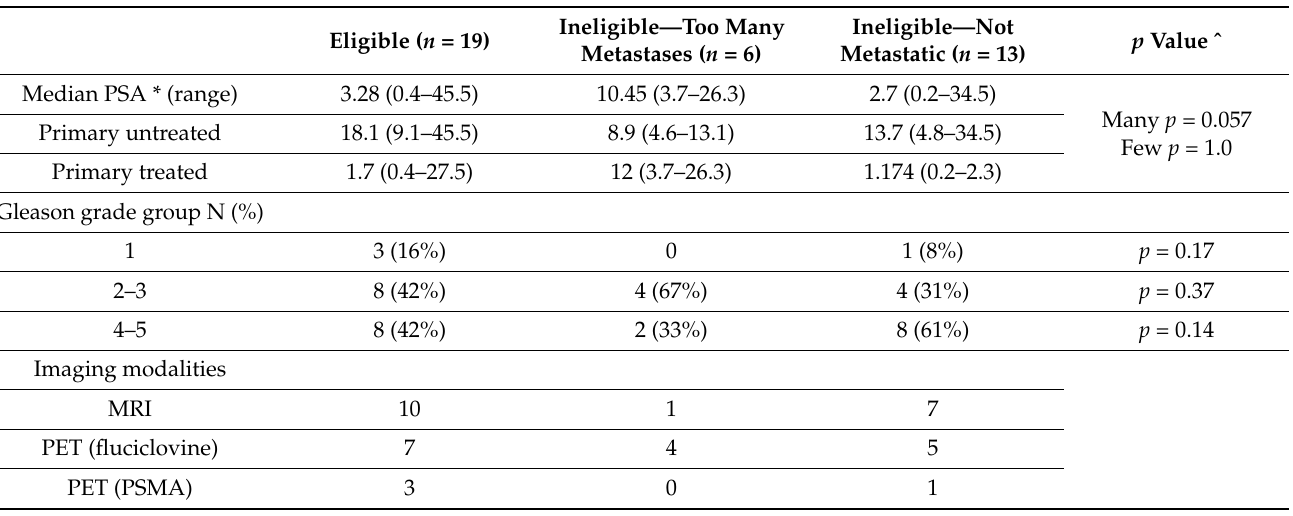
Table 1. Characteristics of eligible and ineligible patients being evaluated for enrollment into the oligometastatic